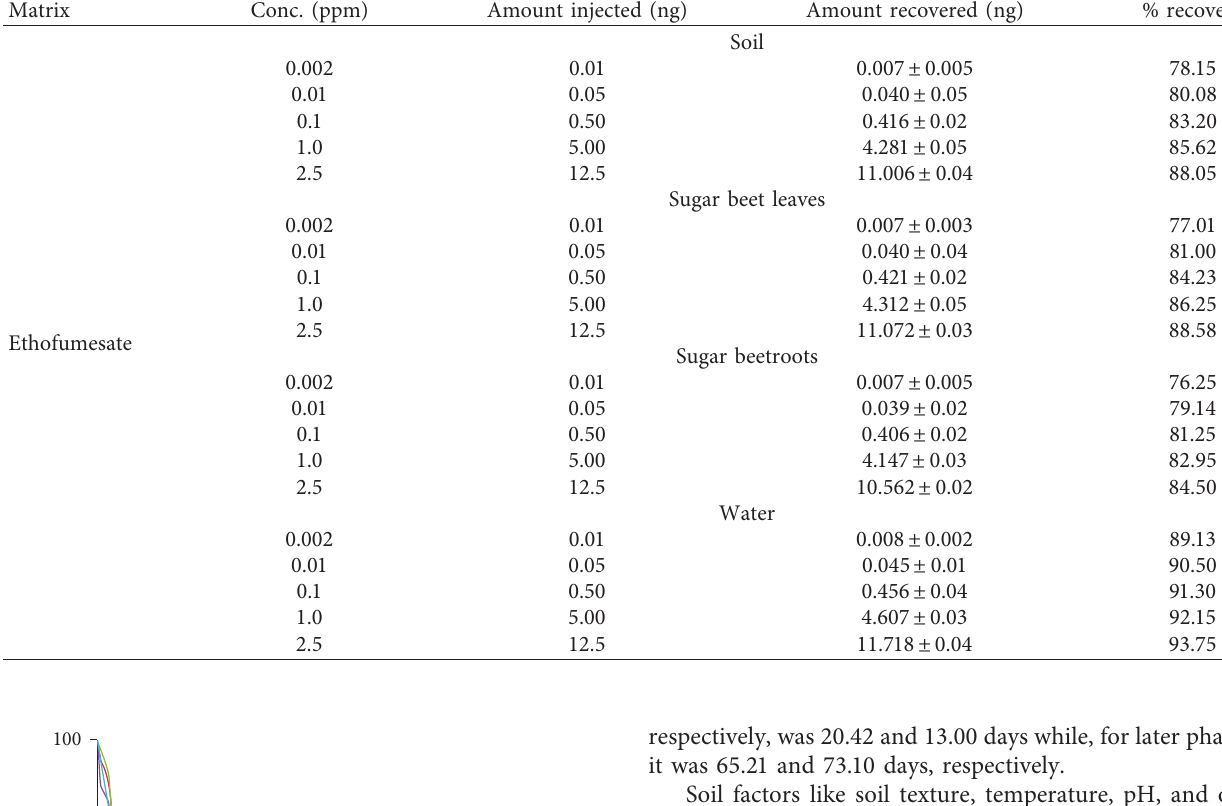
Table 1: Percent recoveries of ethofumesate herbicide from soil, leaves, and beetroot. Matrix